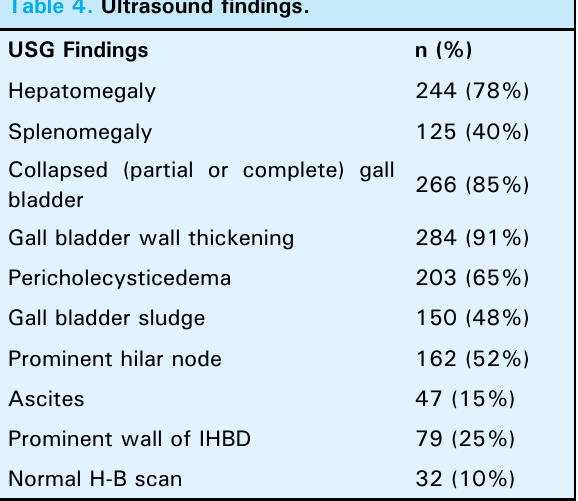
table 4. Ultrasound